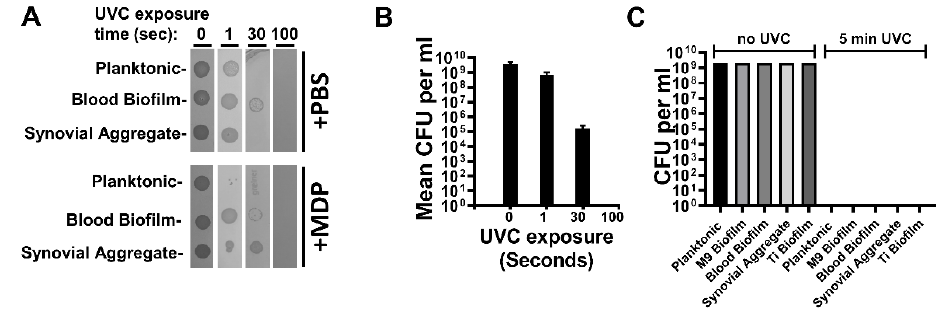
Figure 2. UVC irradiation kills MRSA. ( A ) MDP has minimal impact on MRSA survival following UVC exposure: 100 µL vials of MRSA were exposed to UVC for the indicated times at 2 × 10 8 per tube and spotted onto LB-agar plates to observe residual colony formation activity. Each spot correlates with 2 × 10 6 CFU of bacteria prior to UVC treatment. ( B ) Quantitation of data shown in Panel A. Means with SEM are shown. ( C ) Bar graph showing CFU per mL from samples before and after 5 min of UVC exposure with MDP. Data are representative of >5 independent UVC exposure experiments (depending on the sample). 4 × 10 8 CFU equivalents were plated to check